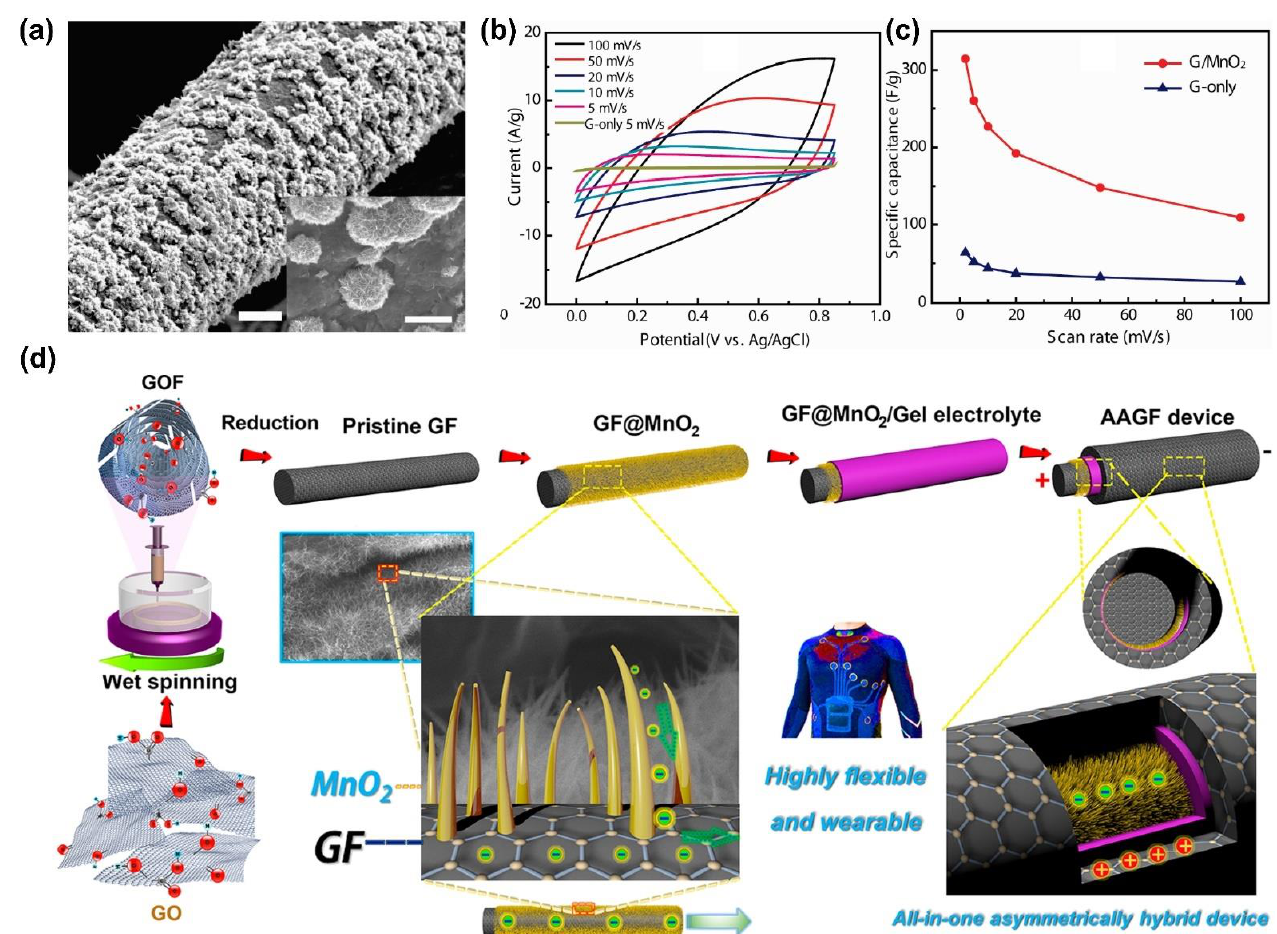
Figure 10. ( a ) SEM image of a typical graphene fiber with conformal coating of MnO 2 nanostructures; ( b ) Cyclic voltammograms for graphene/MnO 2 -textile electrode at different scan rates in 0.5 M aqueous Na 2 SO 4 electrolyte; ( c ) Comparison of specific capacitance values between graphene/MnO 2 -textile and graphene nanosheets-only textile at different scan rates [122] (copyright permission American Chemical Society 2011); ( d ) Schematic illustration of the fabrication route to asymmetric graphene fiber all-in-one device, including wet spinning of GO fibers, reduction of fiber to form core graphene fiber, growth of MnO 2 layer, gel electrolyte coating, and outer graphene layer coating [48] (copyright permission American Chemical Society 2017).